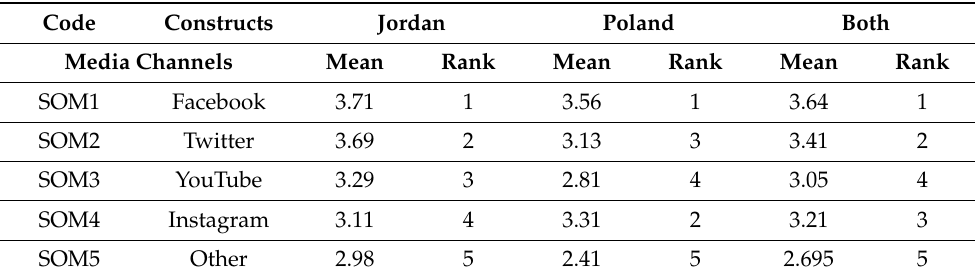
Table 11. Social media platforms’ ranking mean.